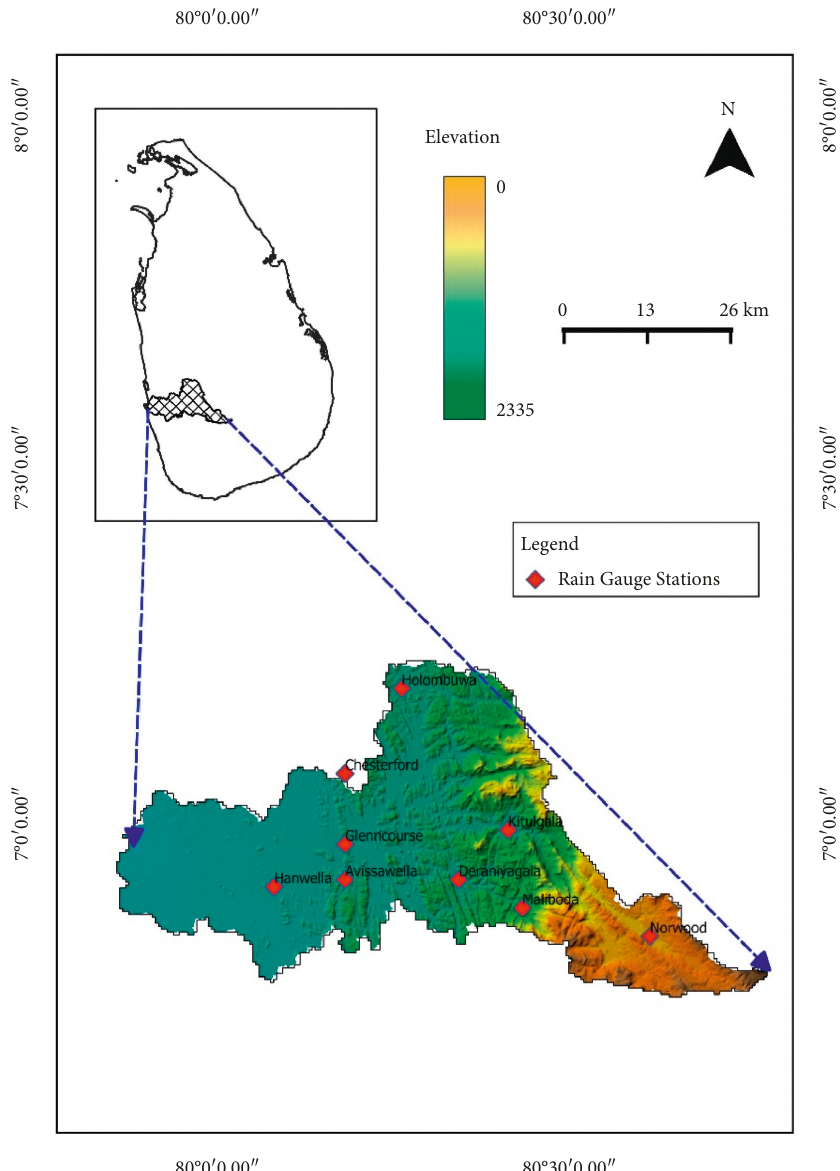
Figure 1: Elevation map of Kelani river